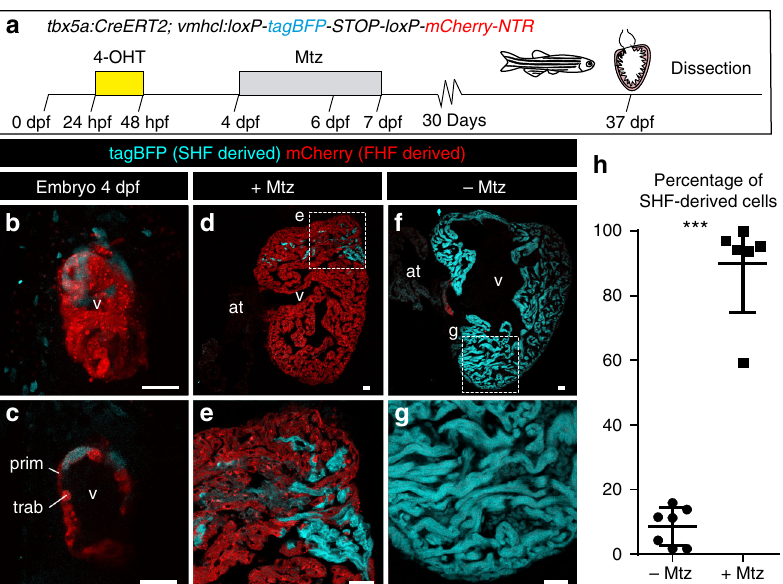
Fig. 4 Genetic ablation of tbx5a -derived ventricular cardiomyocytes. a tbx5a + ventricular cardiomyocytes were genetically ablated in tbx5a : CreER T2 ; vmhcl : loxP-tagBFP-loxP-mCherry-NTR double transgenic zebra fi sh. Recombination was induced by administration of 4-Hydroxytamoxifen (4-OHT). Cell ablation was induced by administration of Metronidazole (Mtz) from 4 to 7 days postfertilisation. b , c Ventral views of larval hearts at 4 dpf (maximal projection and optical section, respectively). Anterior is to the top. The proximal ventricle, including primordial layer and trabeculae, is completely mCherry + and the distal ventricle is blue (tagBFP + ); n = 7/7. d , e Sagittal section of the ventricle of an adult recombined heart. Most cells are mCherry + . Only the tbx5a − region is tagBFP. n = 7/7. f , g , Sagittal section of a Mtz-treated fi sh. Most of the cardiomyocytes are tagBFP + ; n = 6/6. h , Quanti fi cation of the percentage of myocardium that is tagBFP + (SHF-derived), mean ± SD; *** P < 0.0001 by two-tailed unpaired t -test. at, atrium; prim, primordial layer; SHF, second heart fi eld; trab, trabeculae; v, ventricle. Scale bars, 25 μ